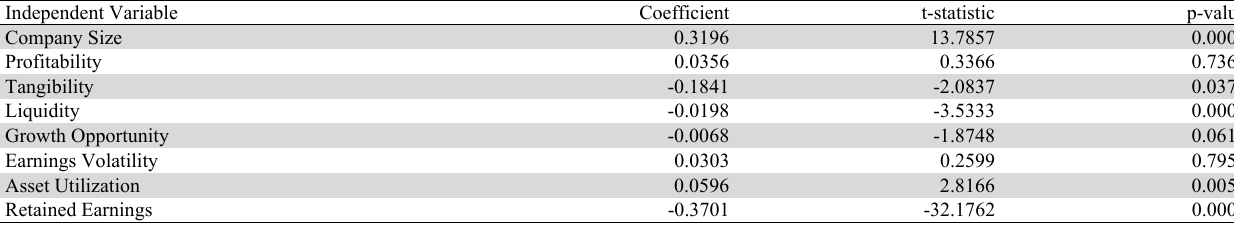
Determining Target Capital